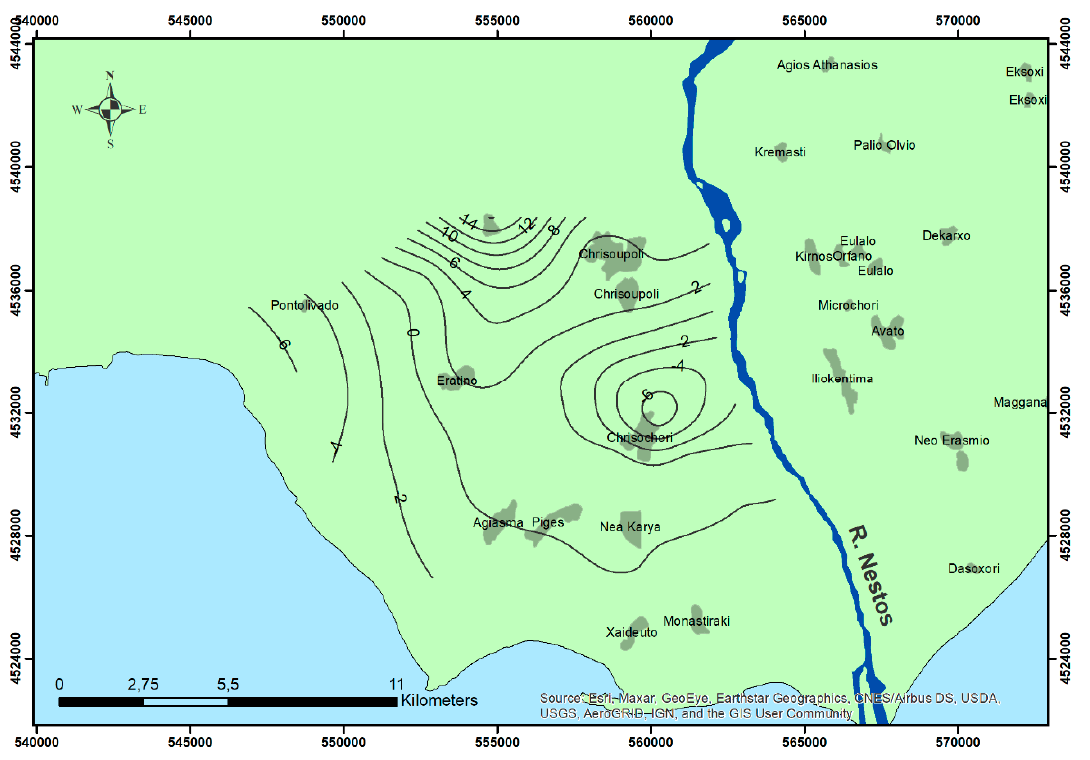
Hydrology 2022 , 9 , x FOR PEER REVIEW Figure 7. Piezometric map of the confined aquifer (May 2019). Figure 7. Piezometric map of the confined aquifer (May 2019).